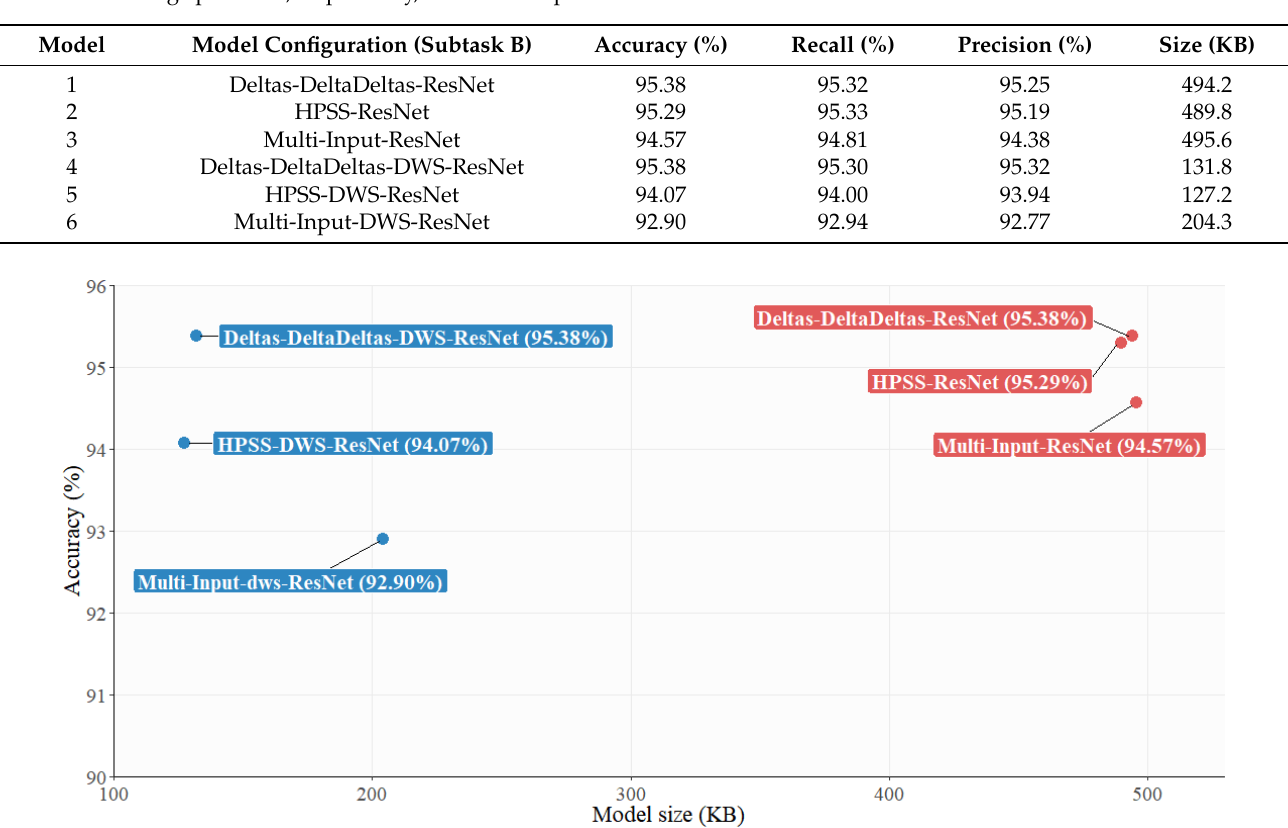
Table 4. Subtask B Results. Accuracy (%), recall (%), and precision (%) are multi-class accuracy, macro-averaged recall and macro-average precision, respectively, of the development set.